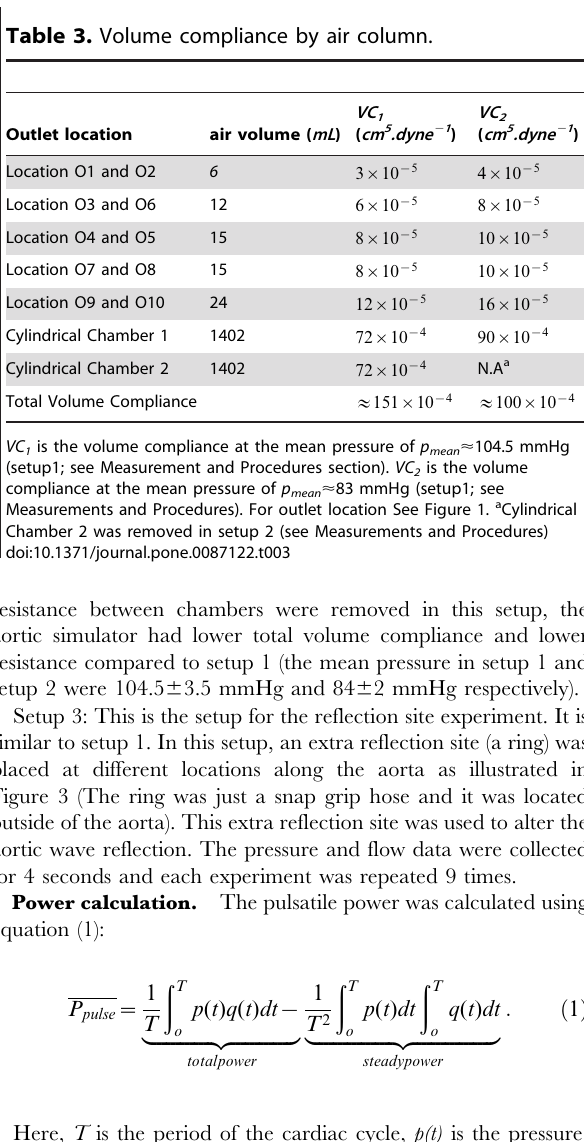
Here, T is the period of the cardiac cycle, p(t) is the pressure, and q(t) is the flow. The pressure and flow were measured at the aortic input. Table 2. Dynamical and physiological properties of the